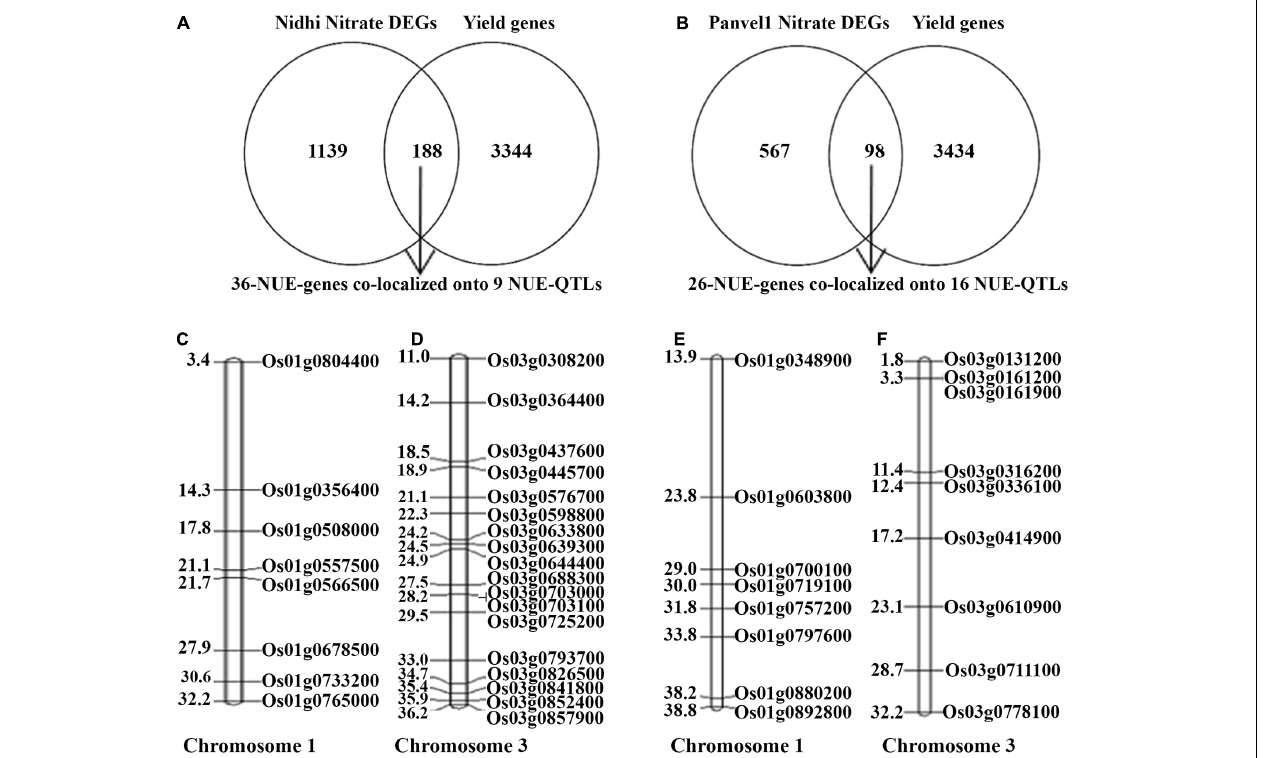
FIGURE 7 | (A) Venn selection of yield-related and Nidhi nitrate genes revealed 188 NUE-genes. Among them, only 36 NUE-genes colocalized onto 9 NUE-QTLs. (B) Venn selection of yield-related and Panvel nitrate genes revealed 98 NUE-genes. Among them, only 26 NUE-genes colocalized to 16 NUE-QTLs. (C,D) Representative figure of Nidhi nitrate NUE genes colocalized on chromosomes 1 and 3. (E,F) Representative figure of Panvel nitrate NUE genes colocalized on chromosomes 1 and 3. Gene id is given on the right side of the map and the physical location of genes is given on the left side of the map (in